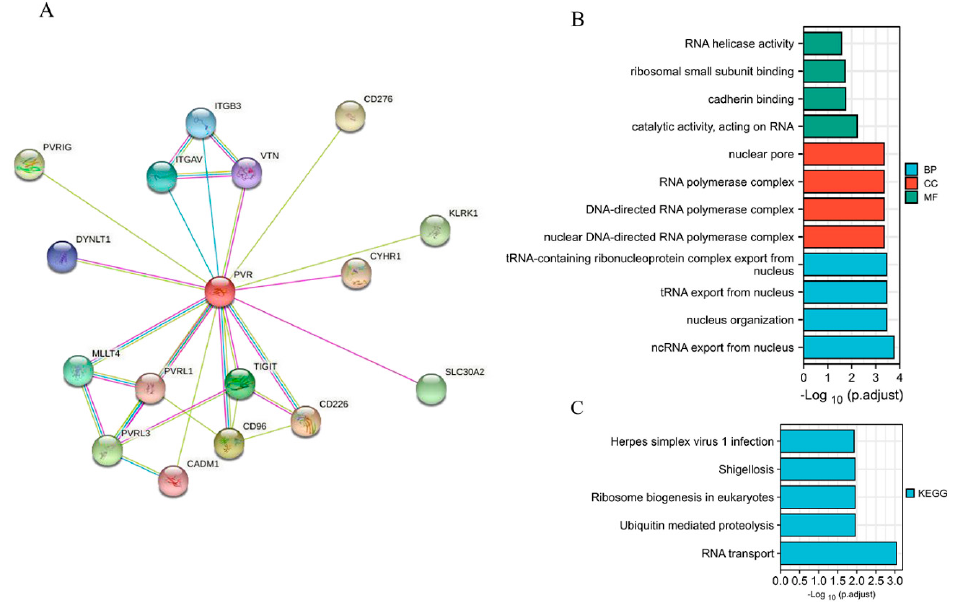
Figure 4. Function and pathway enrichment analysis of PVR in HCC. ( A ) PP1-binding proteins obtained by the STRING tool. ( B ) GO analysis (including BP, MF, and CC) of the top 100 genes. ( C ) KEGG pathway of the top 100 genes correlated with PVR.